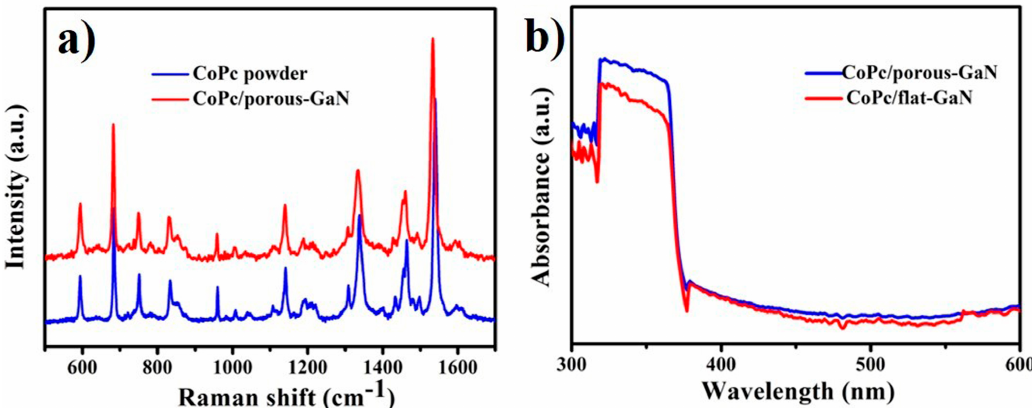
Figure 3. ( a ) Raman spectra of CoPc powder and CoPc/porous-GaN film; ( b ) Optical absorption spectra of CoPc/flat-GaN and CoPc/porous-GaN.